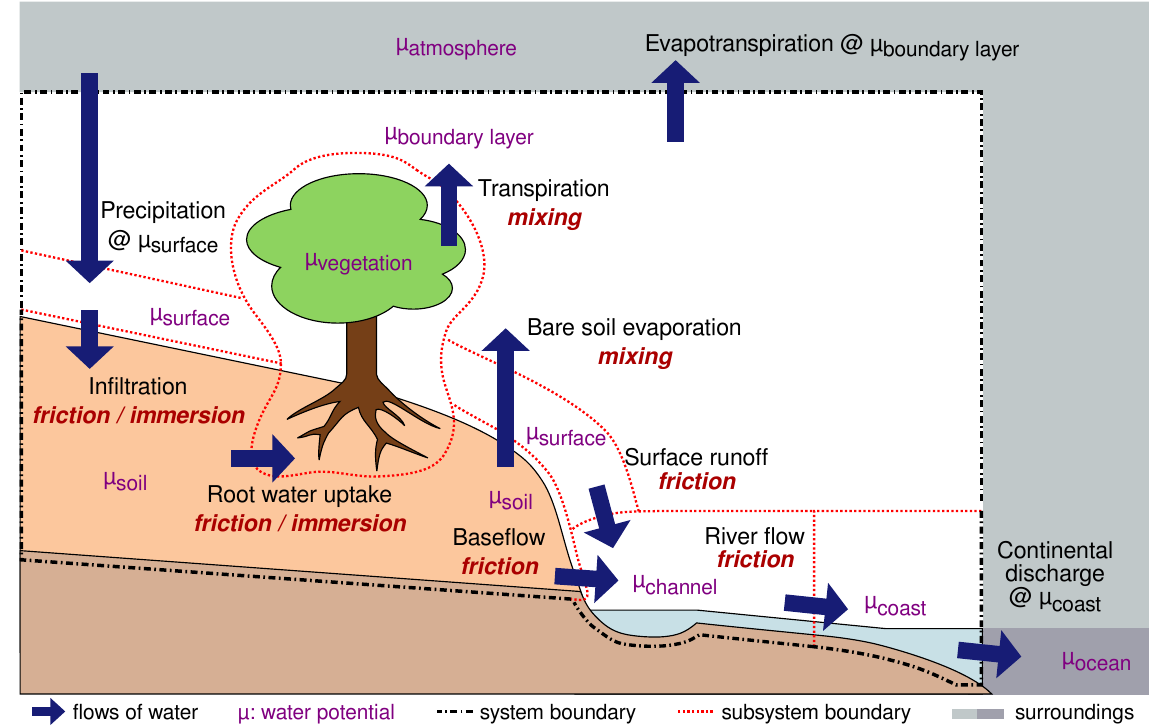
Fig. 1. Overview of the flows of water (black text, regular) and the associated entropy producing dissipative processes (red text, italics) quantified in JESSY and SIMBA. The grey shaded areas correspond to the surroundings of the system.